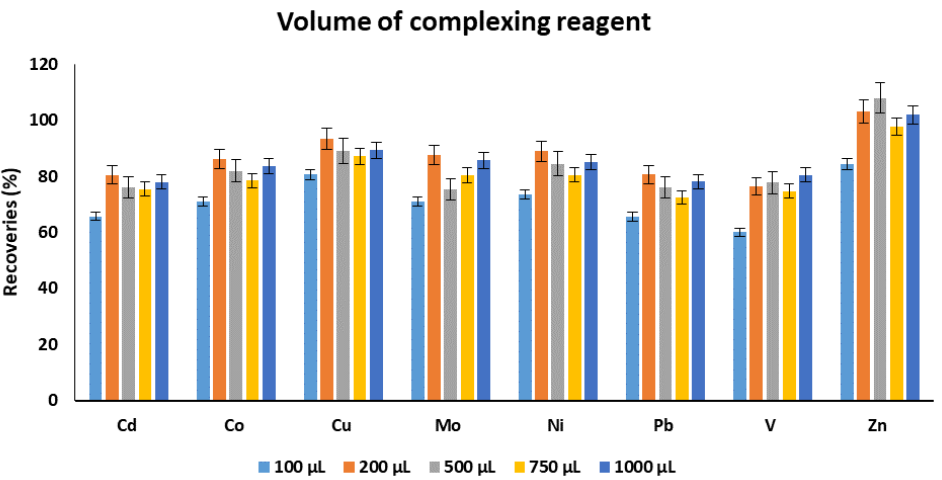
Figure 2. The effect of volume of chelating reagent on the recoveries of target metals. Experimental conditions: sample pH: 4.5, extraction solvent: chloroform, volume of extraction solvent: 10 mL, extraction time: 30 min.